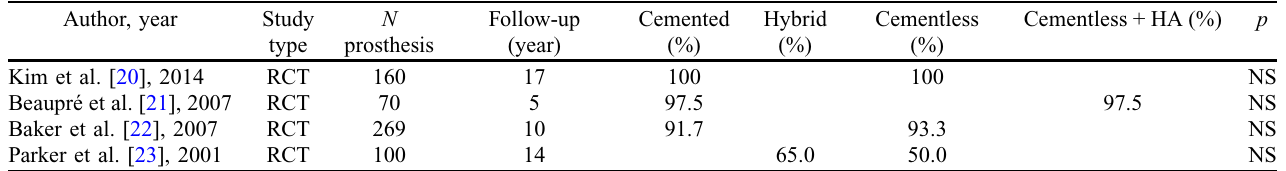
Table 4. Randomized controlled trials comparing cemented and cementless fixation (survivorship endpoint = revision for all